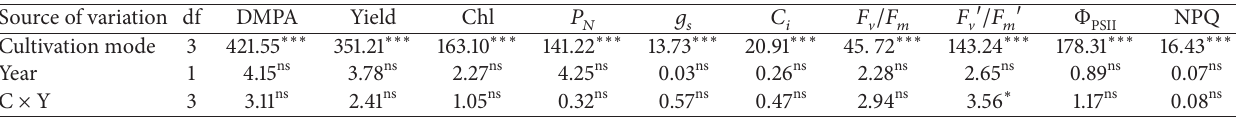
Table 2: Analysis-of-variance ( 𝐹 -values) for chlorophyll (Chl), net photosynthetic rate ( 𝑃 𝑁 ), stomatal conductance ( 𝑔 𝑠 ), intercellular CO concentration ( 𝐶 𝑖 ), maximal quantum yield of PSII photochemistry (𝐹 V /𝐹 𝑚 ) , PSII maximum efficiency ( 𝐹 V 󸀠 /𝐹 𝑚󸀠 ), effective quantum yield of ), and nonphotochemical quenching (NPQ) between/among years and treatments. PSII photochemistry ( Φ PSII Source of variation